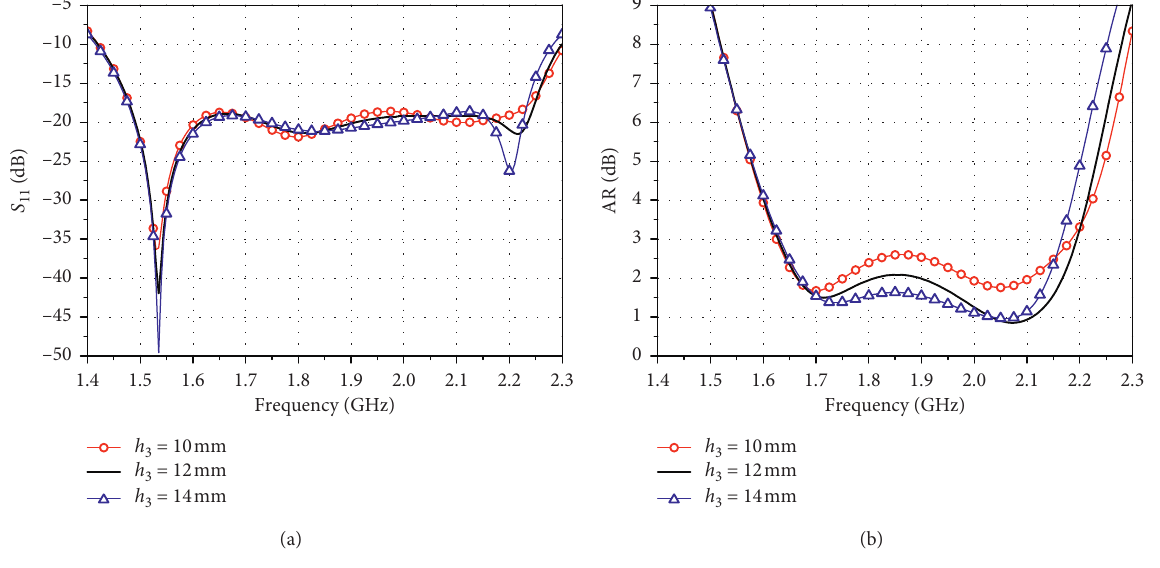
Figure 11: Effects of the height h